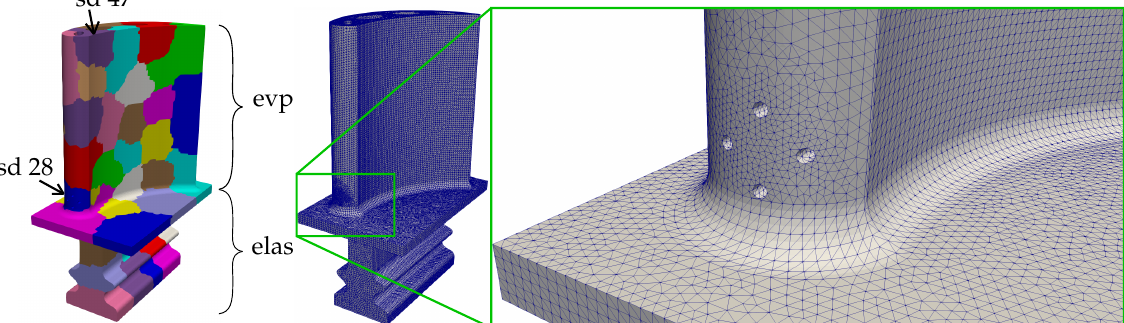
Figure 10. ( left ) Structure split in 48 subdomains—the top part of the blade’s material is modeled by an elastoviscoplastic law and the foot’s one by an elastic law; ( right ) mesh for the high-pressure turbine blade with a zoom around the cooling